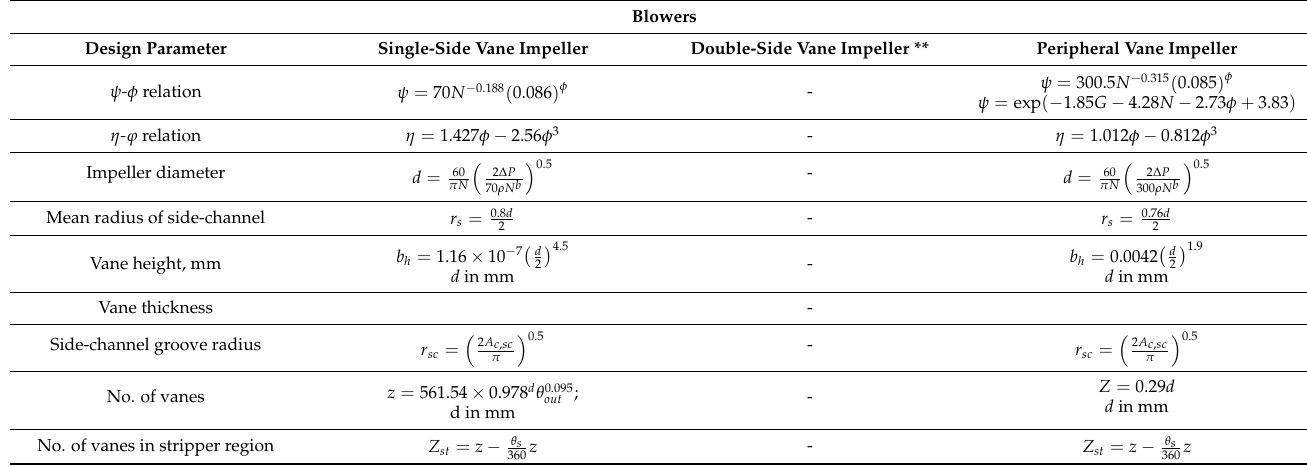
Table 2. Consolidated Table of Correlations for Regenerative Flow Blower